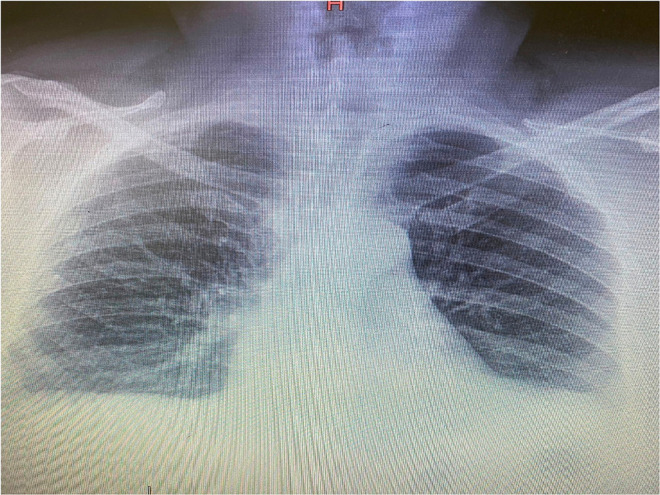
Initial chest X-ray.